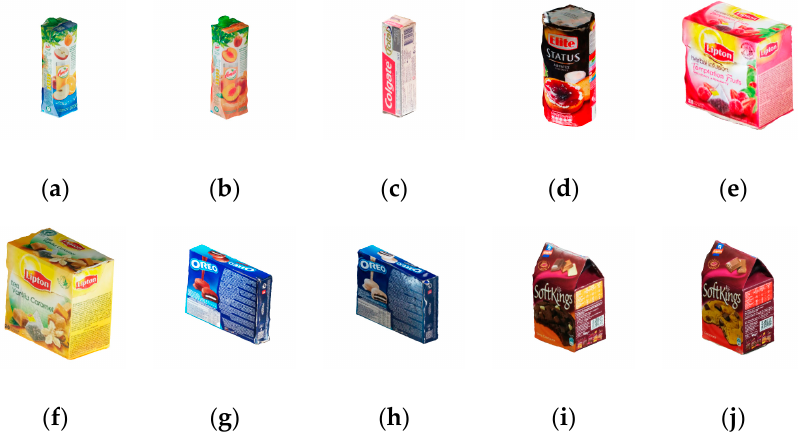
Figure 14. Ten objects in the Doumanoglou dataset: ( a ) Amita–1; ( b ) Amita–2; ( c ) Colgate; ( d ) Elite; ( e ) Lipton–1; ( f ) Lipton–2; ( g ) Oreo–1; ( h ) Oreo–2; ( i ) Soft Kings–1; ( j ) Soft Kings–2.